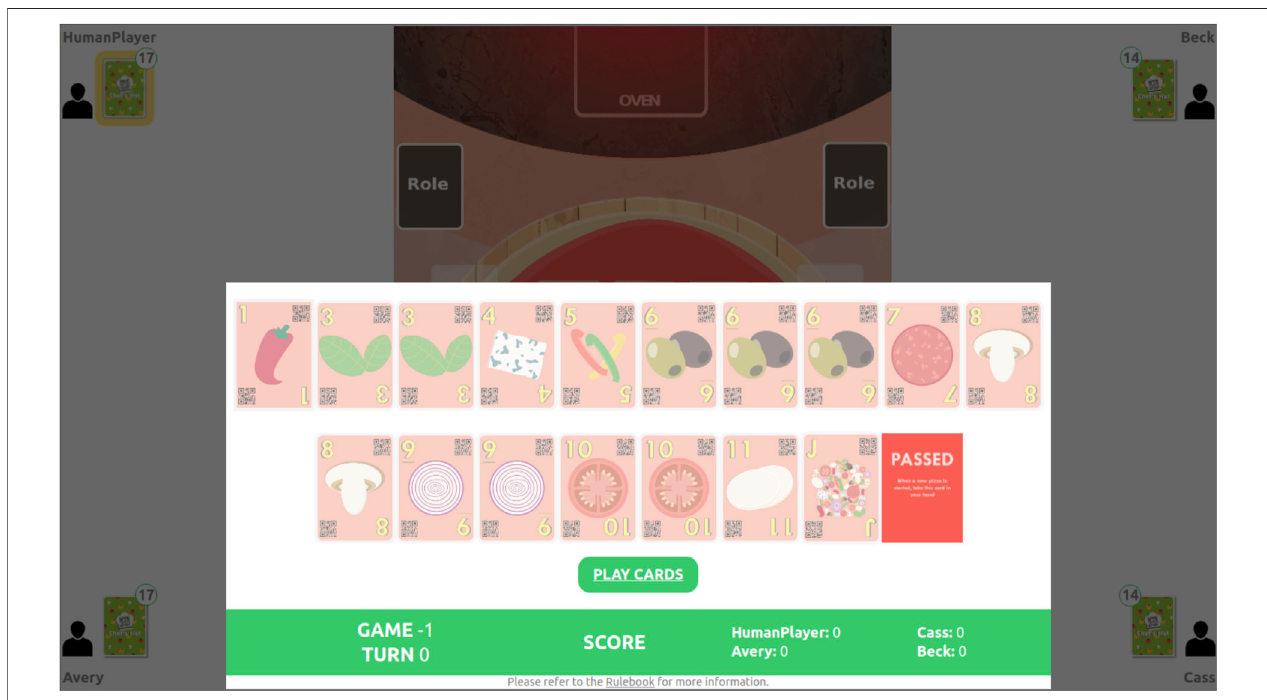
FIGURE 5 | Chef ’ s Hat Online interface allows humans to play against trained agents. This solution allows the collection and exporting of the entire gameplay in a format compatible with the Chef ’ s Hat Gym environment.